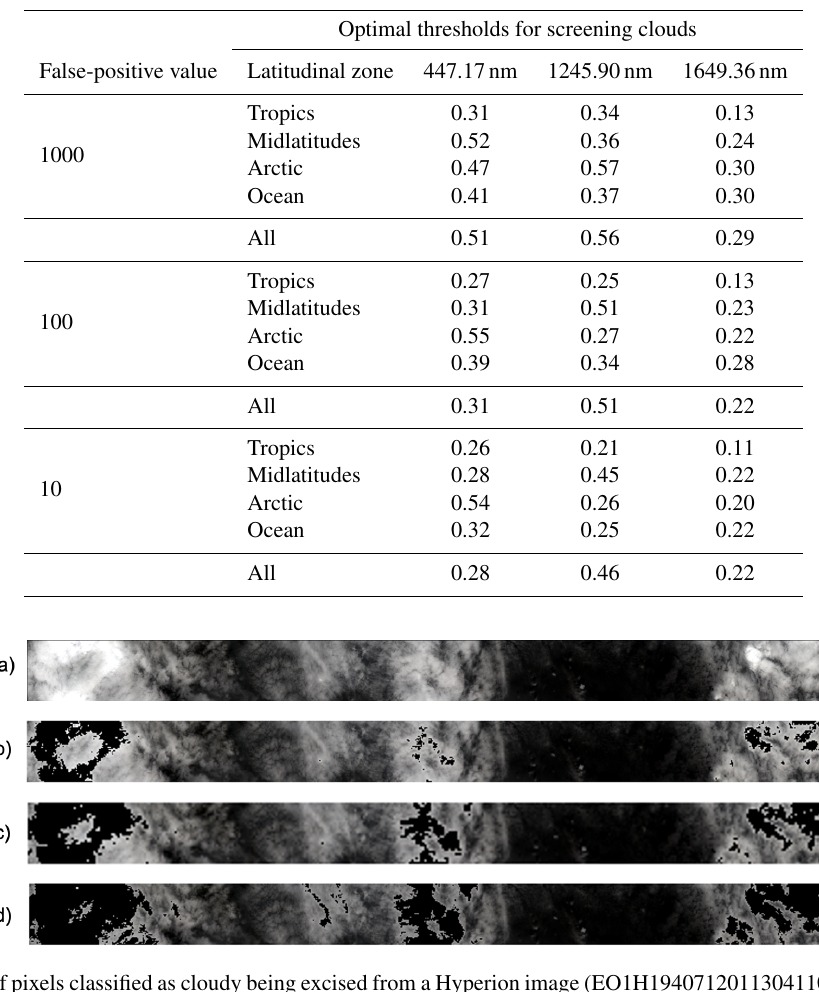
Table 2. Optimal thresholds in TOA (top-of-the-atmosphere) reflectance values using three difference false positives and a false negative of 1 for each latitudinal zone.